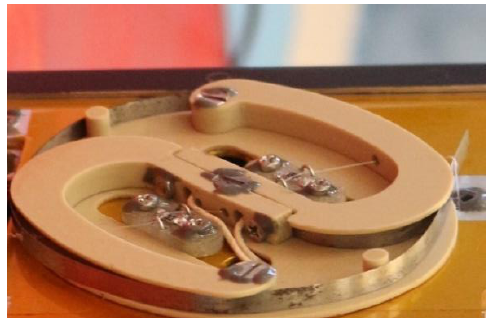
Figure 7. CAD model of the antenna deployment system .